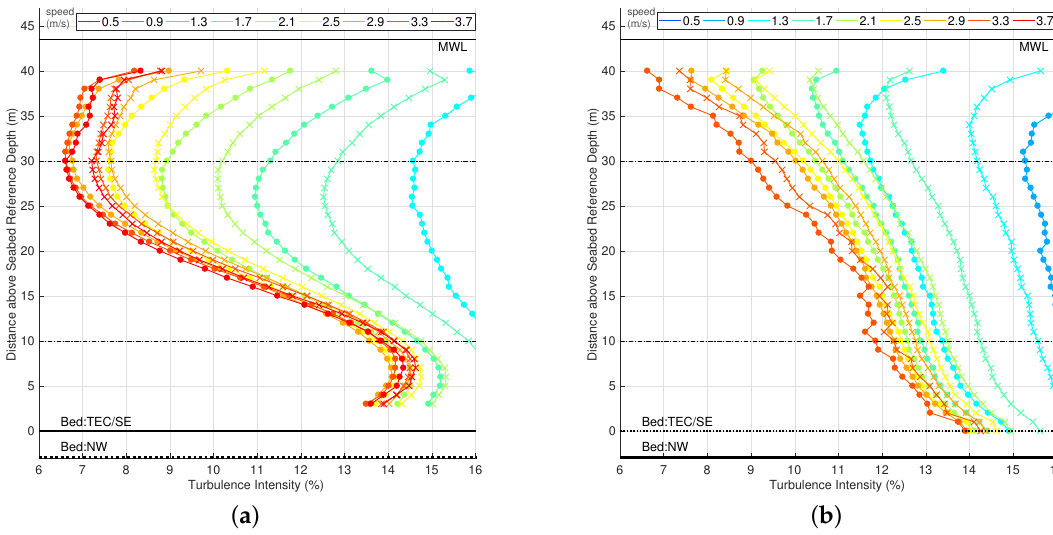
Figure 11. Aggregate (averaged over four instrument deployments per tide) depth profiles of TI for ( a ) ebb and ( b ) flood tides with noise correction implemented. Profiles featuring noise correction are marked by filled circles: uncorrected raw profiles are shown as crosses. ( a ) Aggregate ebb tide TI depth profiles. ( b ) Aggregate flood tide TI depth